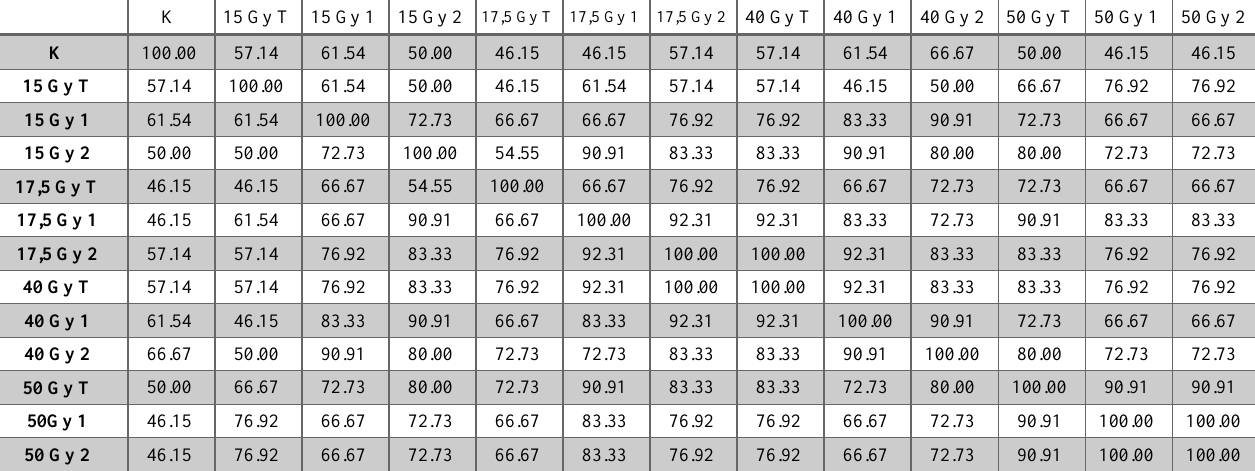
Table 3. The genetic similarity matrix of Ocimum basilicum , gained by the UBC 856 primer K